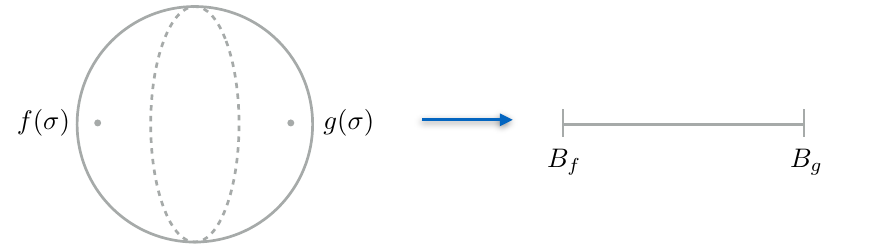
Figure 4. Supersymmetric quantum mechanics formulation of A -model correlation functions in the limit q !